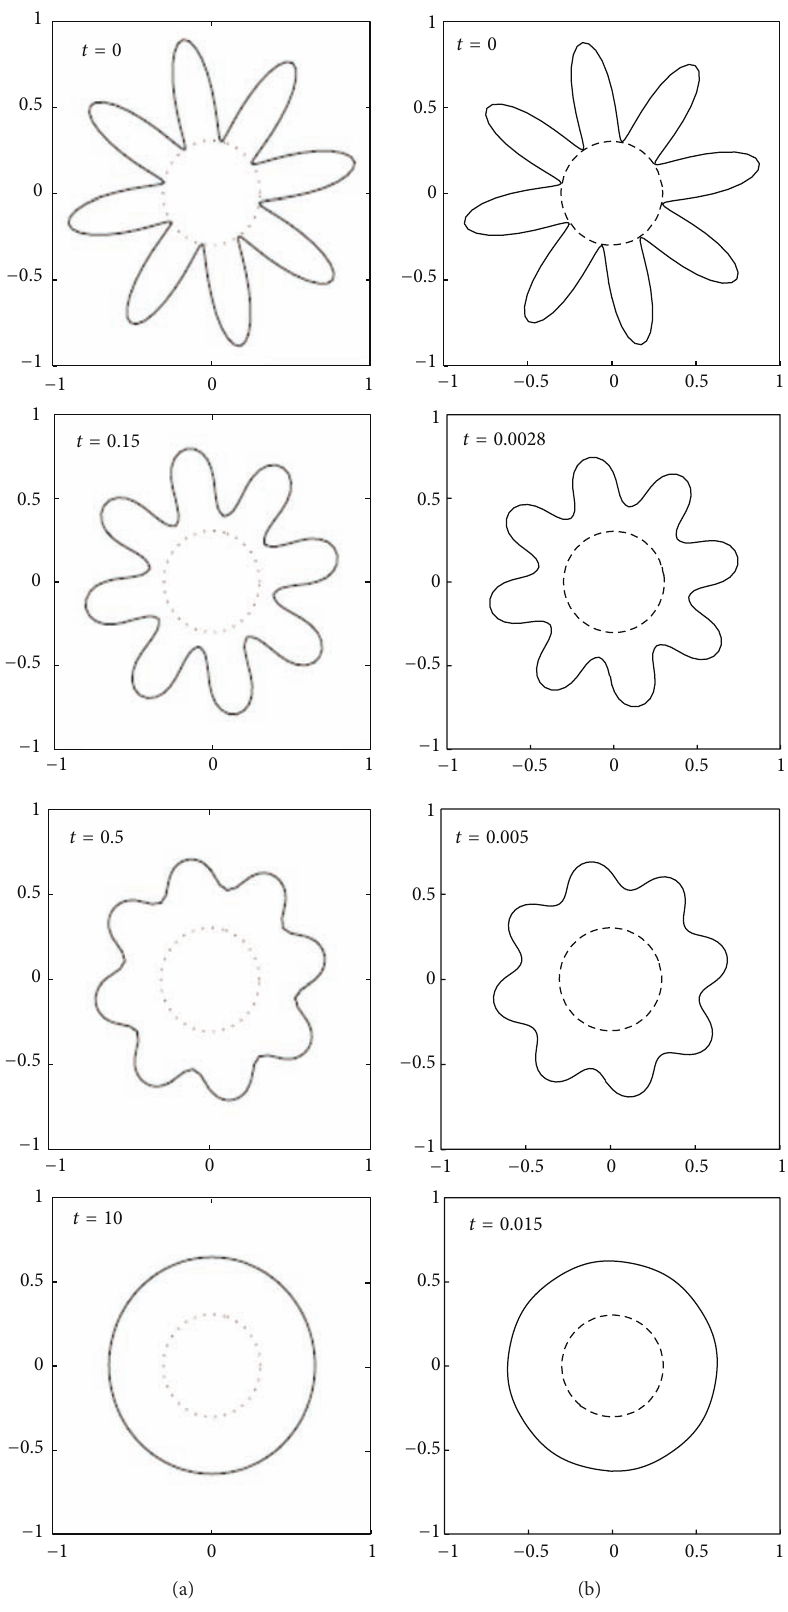
Figure 4: Interface of the star balloon at different times. The dotted circle represents the unstretched interface with 𝑟 = 0.3 (a): IIM and (b):